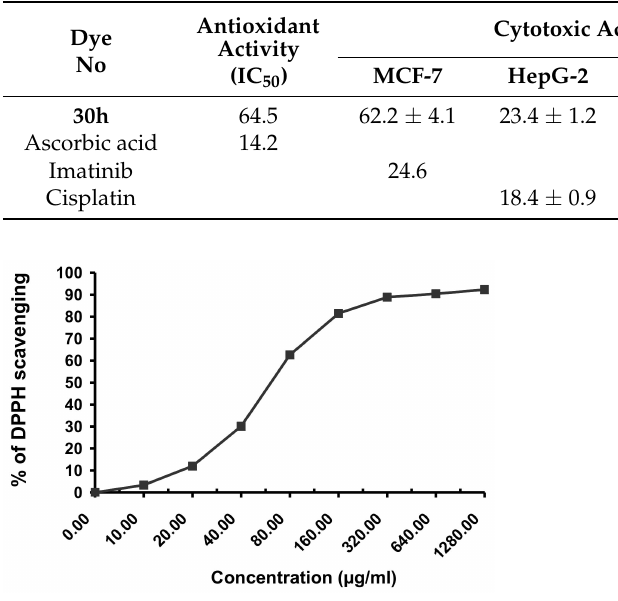
Figure 9. Antioxidant effect of dye 30h .